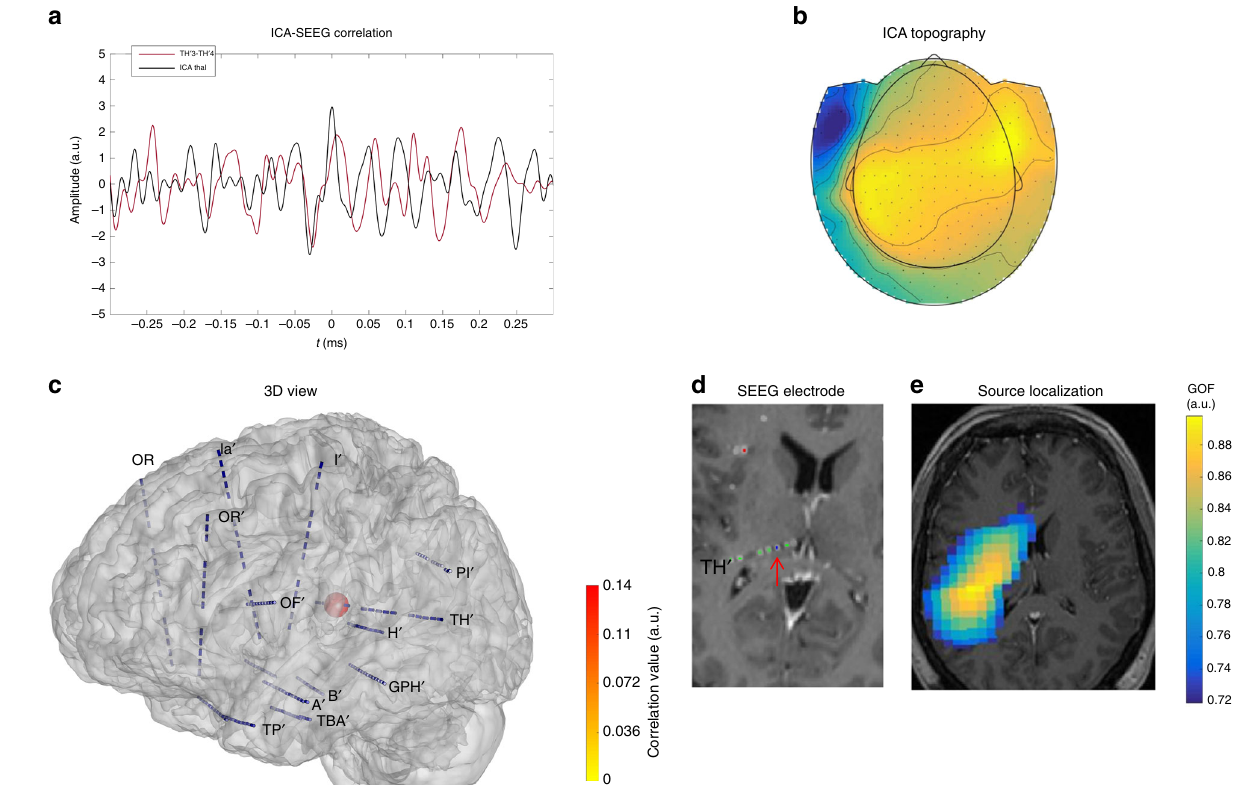
Fig. 3 ICA component correlated with the thalamus in P12 ( “ SEEG-triggered analysis ” ). a In black, ICA time course and in color (red), time course on the SEEG contact where signi fi cant correlation with ICA was measured. b MEG topography of ICA component. c 3D representation of MEG-SEEG correlation. Color (from yellow to red, refer to color bar) and sphere dimension correspond to the correlation value. d MRI (T1) with reconstructed SEEG electrodes (showing electrode TH ’ ); the arrow indicates the contact with the highest correlation value, located in the left thalamus. e Source localization (single dipole) of the ICA component overlaid on patient MRI, which includes regions sampled by mesial contacts of electrode TH